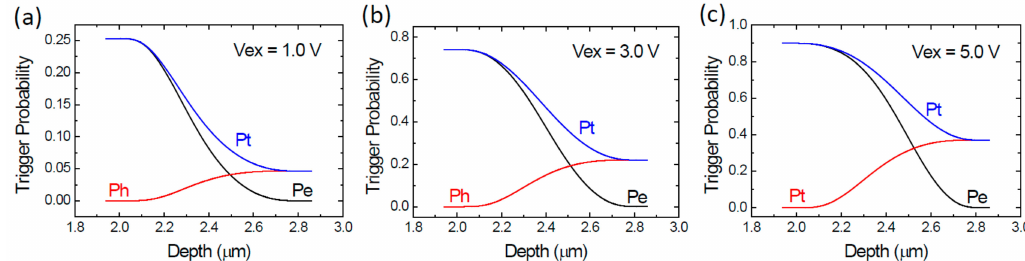
Figure 3. Simulated electron ( P e ), hole ( P h ), and total ( P t ) trigger probabilities as a function of the depth at device center ( r = 0 µ m) at the three excess voltages Vex. ( a ) Vex = 1.0 V; ( b ) Vex = 3.0 V; ( c ) Vex = 5.0 V.